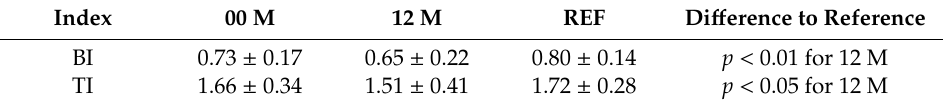
Table 1. Calculated Bone Index (BI) and Texture Index (TI) in intraoral